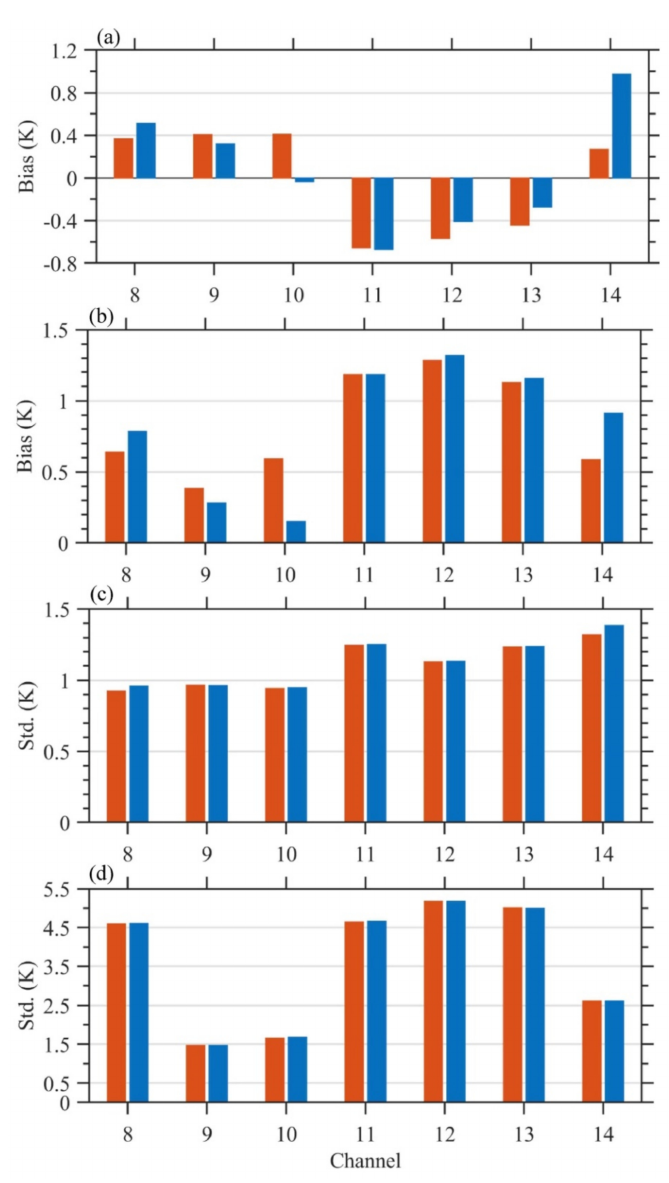
Figure 6. ( a , b ) Mean biases and ( c , d ) standard deviations calculated by OMB ARMS (orange) and OMB RTTOV (blue) with ERA5 data as input statistics for clear–sky data in January, April, July, and October 2019, over ( a , c ) the ocean and ( b , d ) land with satellite zenith angles less than 60 ◦